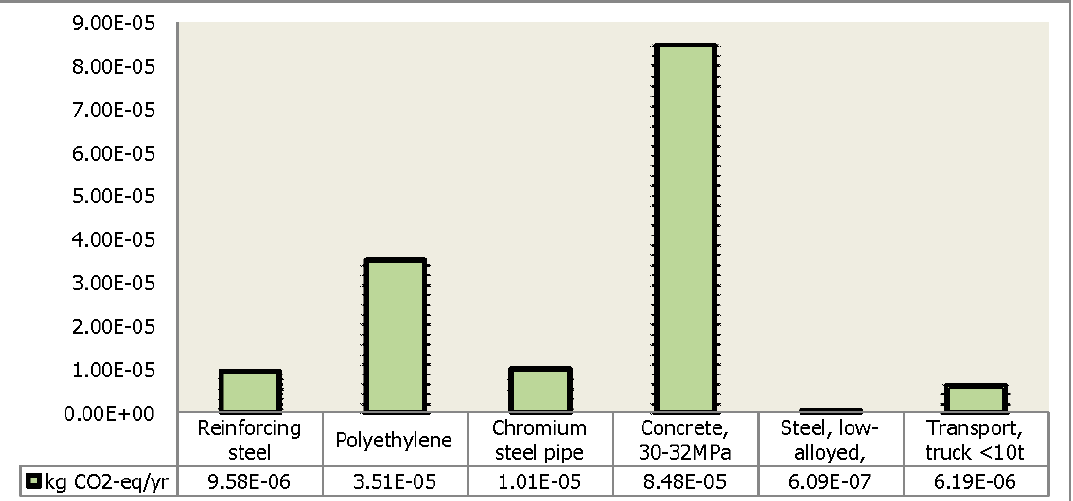
Figure 2. GHG emissions for the Senok SWRO desalination construction stage.